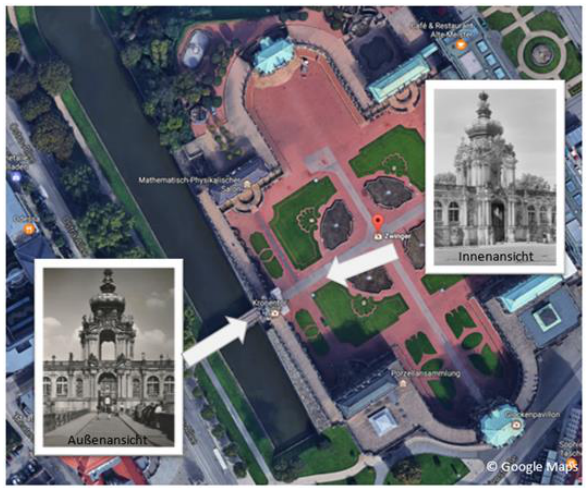
Figure 1. Overview of the Zwinger with historical images of the Kronentor (Google maps)